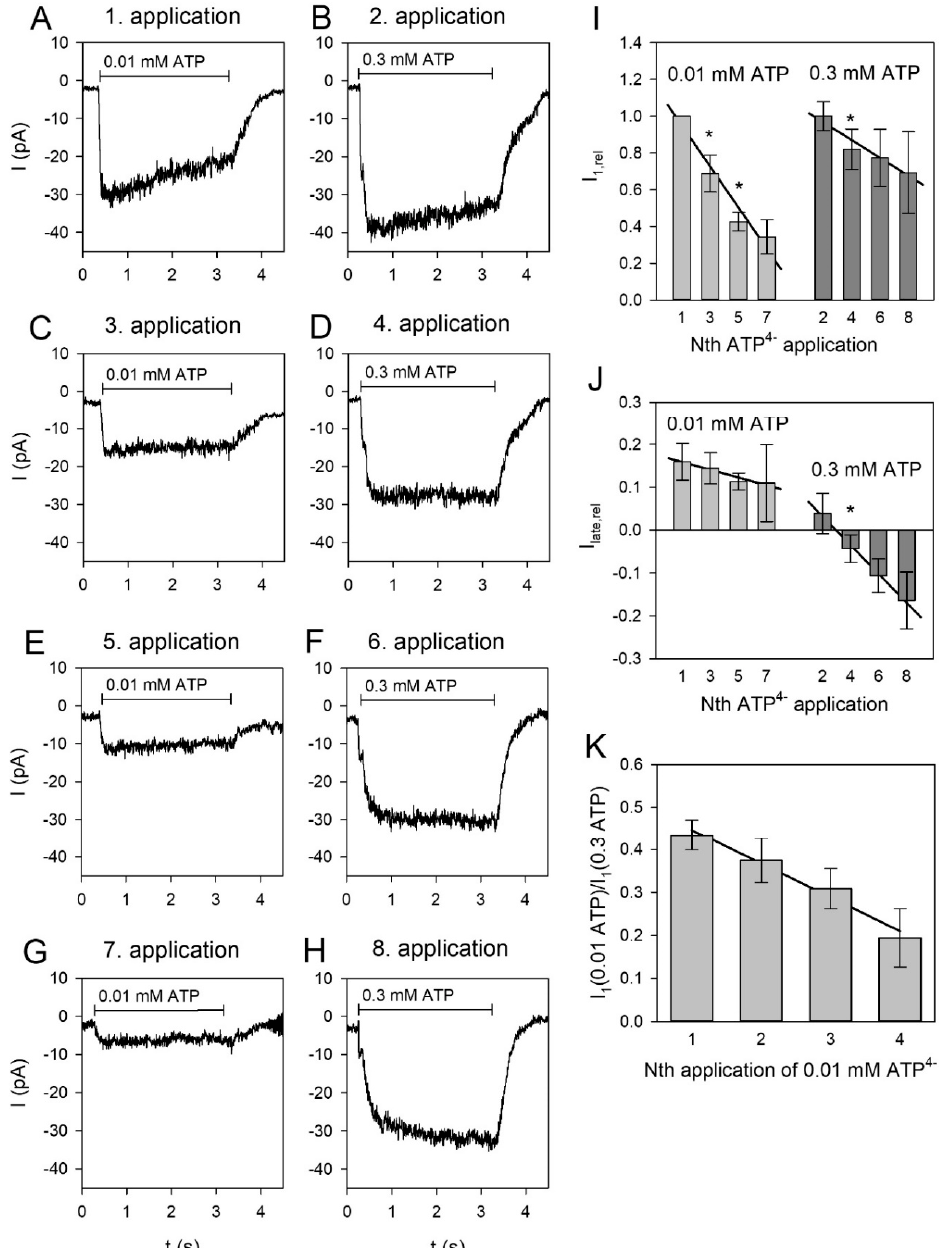
Figure 5. Long-term desensitization of ATP-dependent currents in BV-2 cells. Currents were alternately activated by 0.01 and 0.3 mM ATP 4 − . ( A – H ) Representative current traces elicited consecutively by 0.01 and 0.3 mM ATP 4 − as indicated. The time between the ATP applications was 1 min. ( I ) Dependence of the current amplitudes on the number of ATP applications with significantly different regression coefficients for 0.3 mM ATP 4 − ( − 0.11 ± 0.02) and for 0.01 mM ATP 4 − ( − 0.25 ± 0.05). The current amplitudes were related to the first application (0.01 mM ATP 4 − ). The amplitudes of the currents elicited by 0.3 mM ATP 4 − were scaled by the amplitude of the current evoked by the first 0.3 mM ATP 4 − application. ( J ) Application dependence of the relative late currents with the significantly regression coefficients for 0.3 mM ATP 4 − ( − 0.07 ± 0.02, significantly different from 0) and for 0.01 ATP 4 − ( − 0.019 ± 0.03, not significantly different from 0) ( B ). ( K ) Dependence of the relative current amplitudes I 1 of the currents elicited by 0.01 mM ATP 4 − and by the following 0.3 mM ATP 4 − application. The regression coe ffi cient was − 0.072 ± 0.02, which was significantly di ff erent from 0. Means ± SEM of 4-312 cells. Significant di ff erences to the previous application are marked by